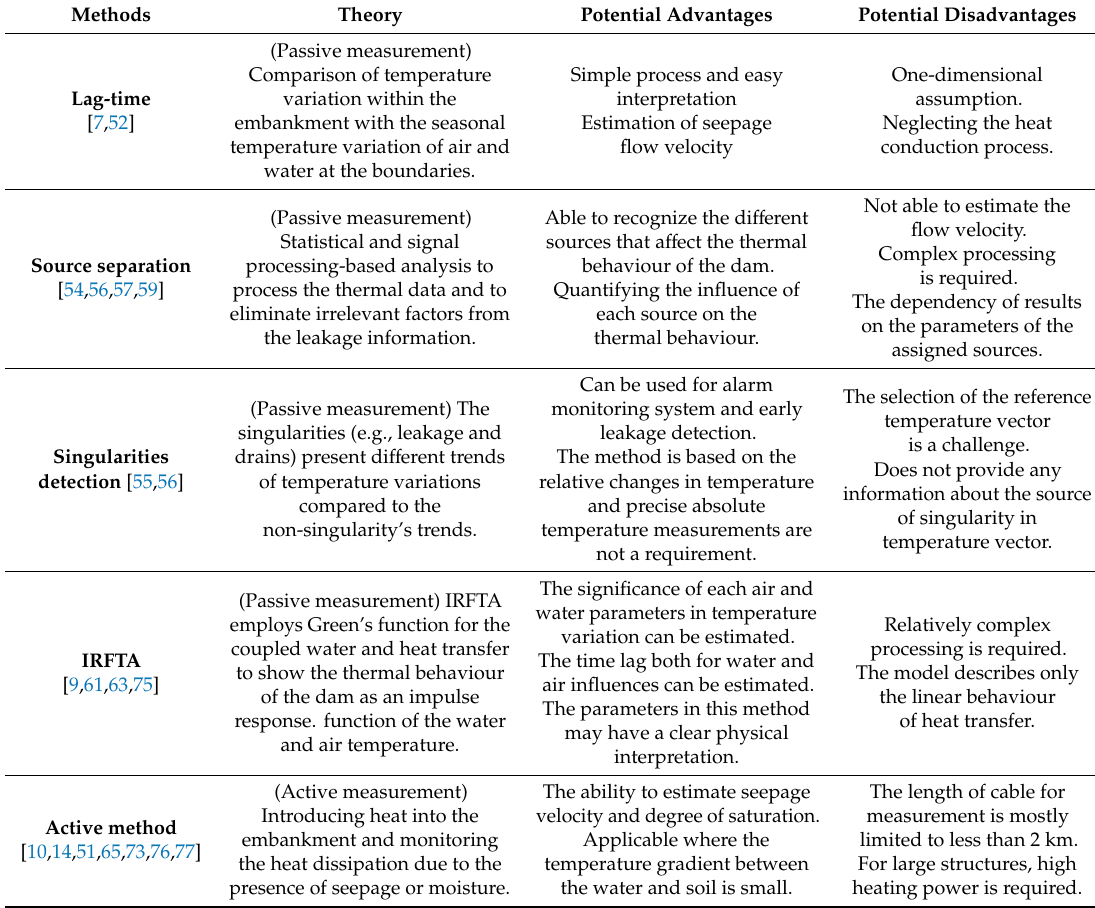
Table 2. Comparison of di ff erent techniques for DTS application in seepage